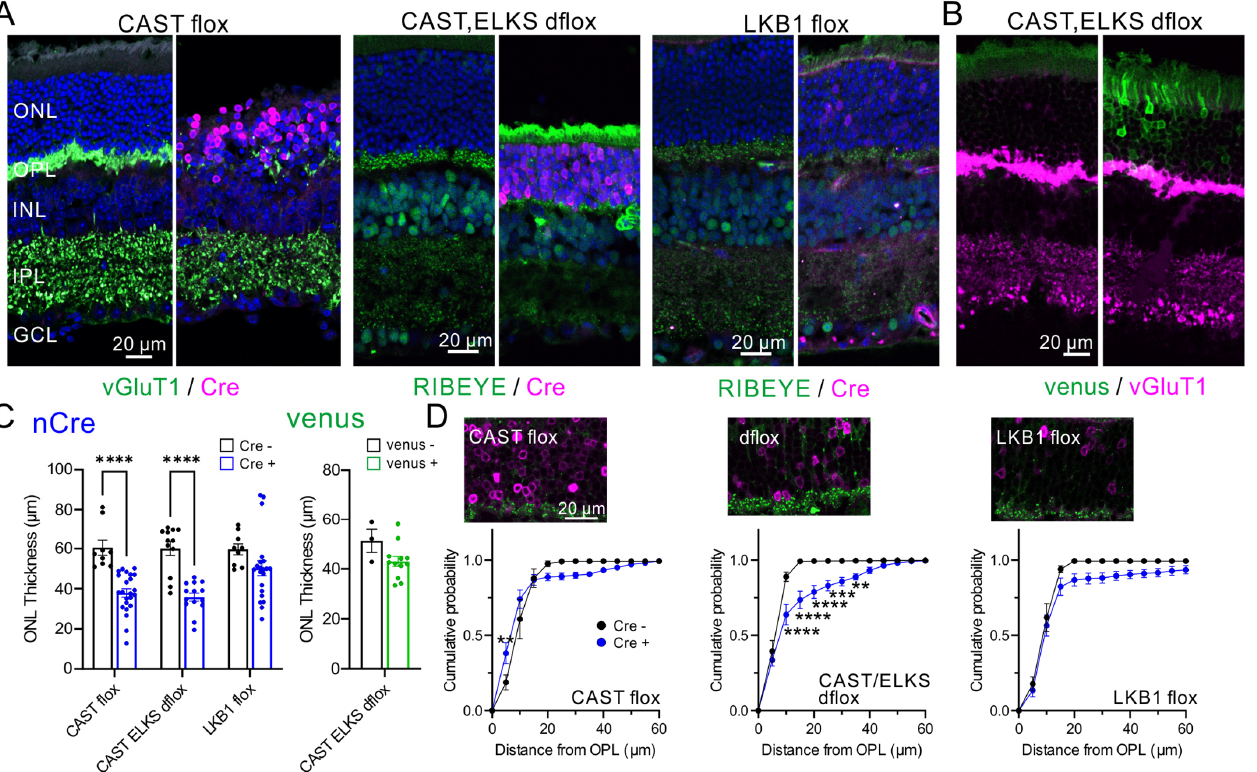
Figure 4. Acute depletion of CAST and ELKS causes photoreceptor degeneration in the mature retina. ( A , B ) Acute expression of Cre recombinase using AAV5-CAGGS-nCre in CAST flox, CAST/ELKS dflox, and LKB1 flox mouse. Subretinal injection of AAV5 produces mosaic Cre expression in the retina, which can be identified by immunolabeling for Cre (magenta). AAV-mediated Cre expression causes reduced ONL thickness, indicating photoreceptor degeneration, with ablation of CAST and ELKS. Further, RIBEYE or vGluT1 immunolabeling reveals reduced ribbon synapses in the OPL (green). As a negative control, AAV-mediated expression of Venus had no effect on layer thickness or vGluT1-labeled photoreceptor terminal in the OPL (magenta) in CAST and ELKS dflox retina. ( C ) Quantitative analysis of ONL thickness in CAST-flox, CAST/ELKS-dflox and LKB1-flox cKO mice. The thickness was significantly decreased in the CAST flox and CAST/ELKS dflox mice but was unchanged in the LKB1 flox. **** p < 0.0001 (two-way ANOVA with post hoc Sidak test). The AAV5-CAGGS-venus expression in CAST/ELKS-dflox mice did not affect ONL thickness (Student’s t -test). ( D ) Cumulative histogram of the distance probability of RIBEYE-labeled ribbon synapse distribution. In the Cre-negative region, the frequency curve reached ~100% within 15–20 μ m, indicating normal ribbon synapse localization in the OPL (black line). However, in the CAST/ELKS dflox mice, the frequency curve at the Cre expressing region (presumably depletion of CAST and ELKS, blue line) was shifted to the right, with approximately 20–30% of ribbon synapses ectopically localized in the ONL. Mean ± SEM; CAST-flox: Cre negative: n = 5, Cre positive: n = 7; CAST/ELKS-dflox: Cre negative: n = 9, Cre positive: n = 8; LKB1-flox: Cre negative: n = 5, Cre positive: n = 6. ** p < 0.01, *** p < 0.001, **** p < 0.0001 (two-way ANOVA with post hoc Sidak test).